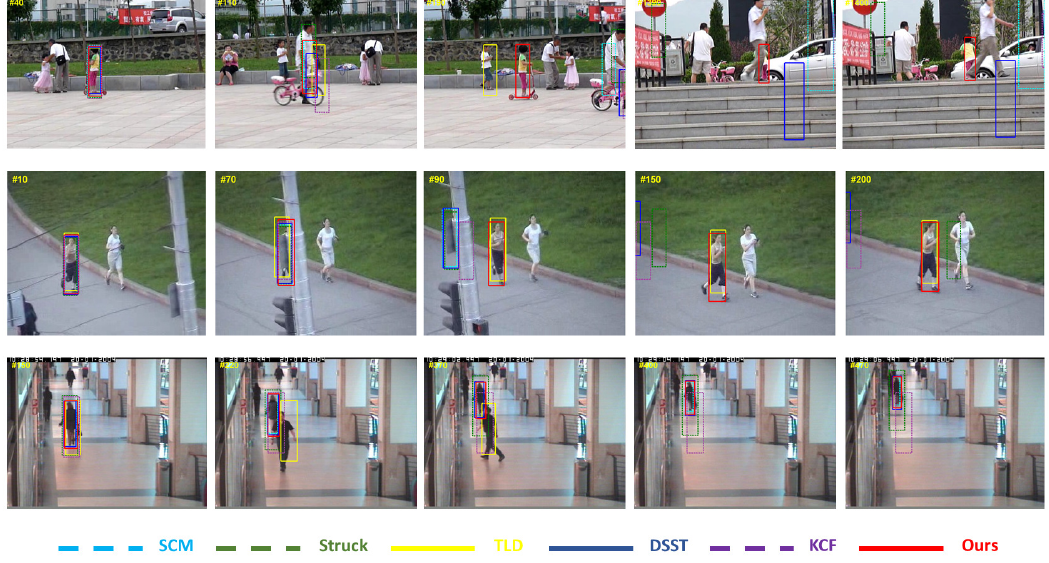
Figure 6. Screenshots of some tracking results in occlusion sequences. These frames are extracted from sequences girl2 , jogging and walking2 , from top to